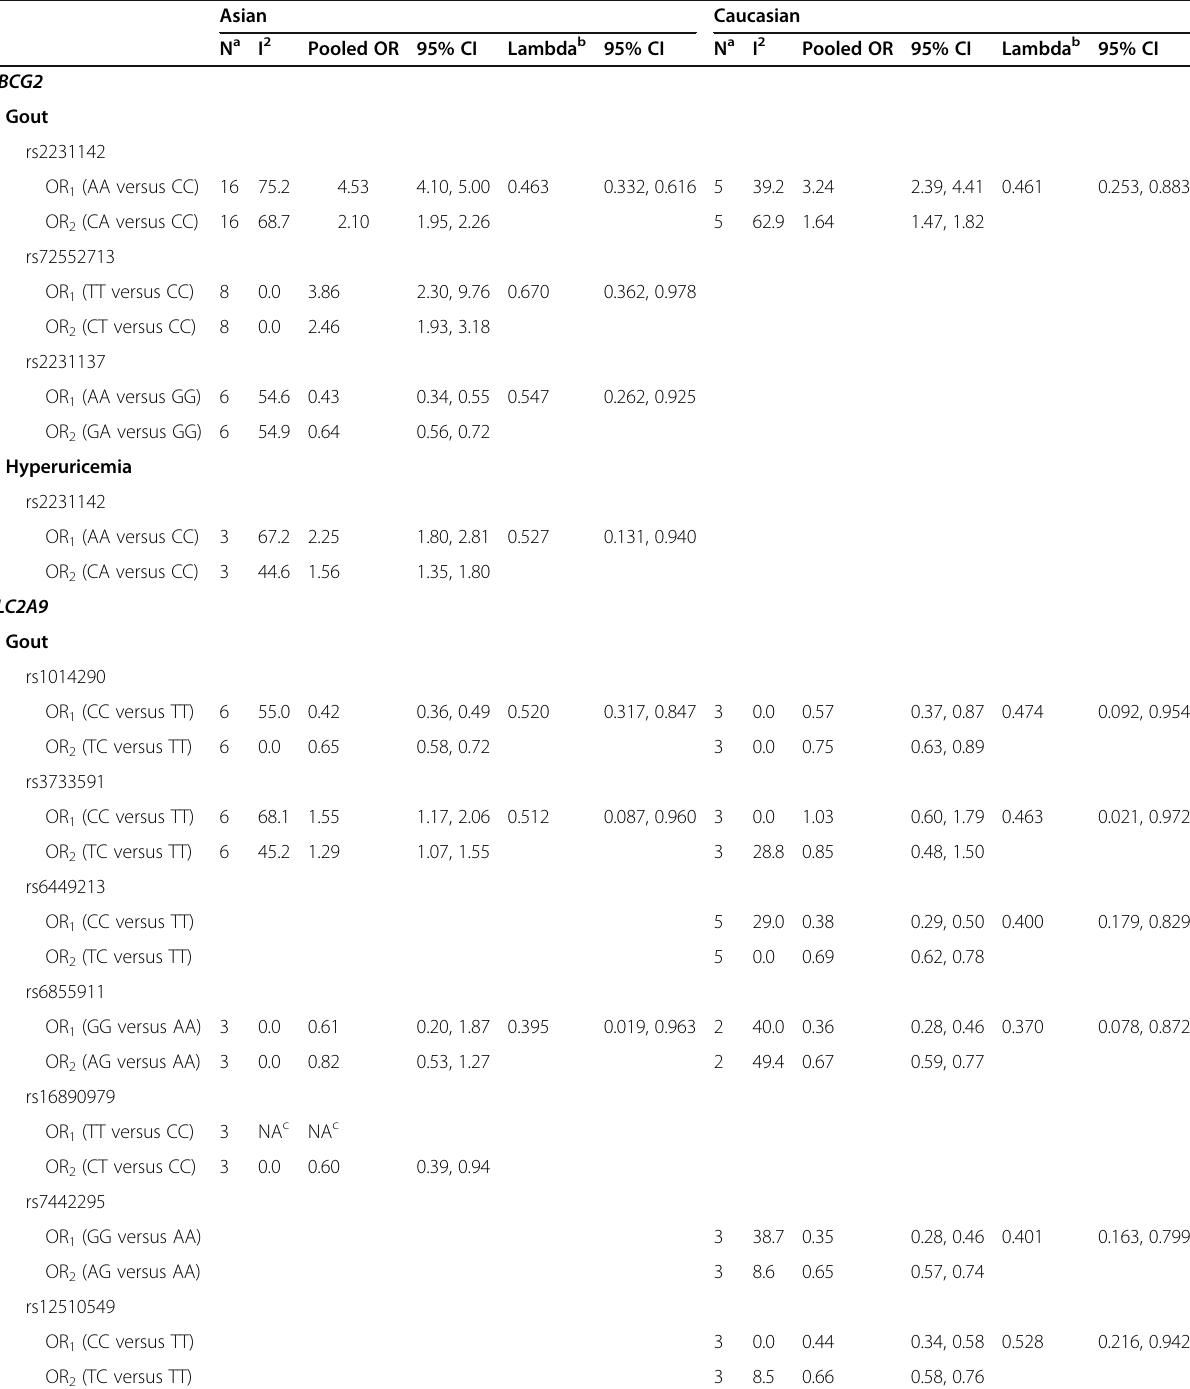
Table 1 Summary of pooled effect sizes of ABCG2 and SLC2A9 polymorphisms on gout and